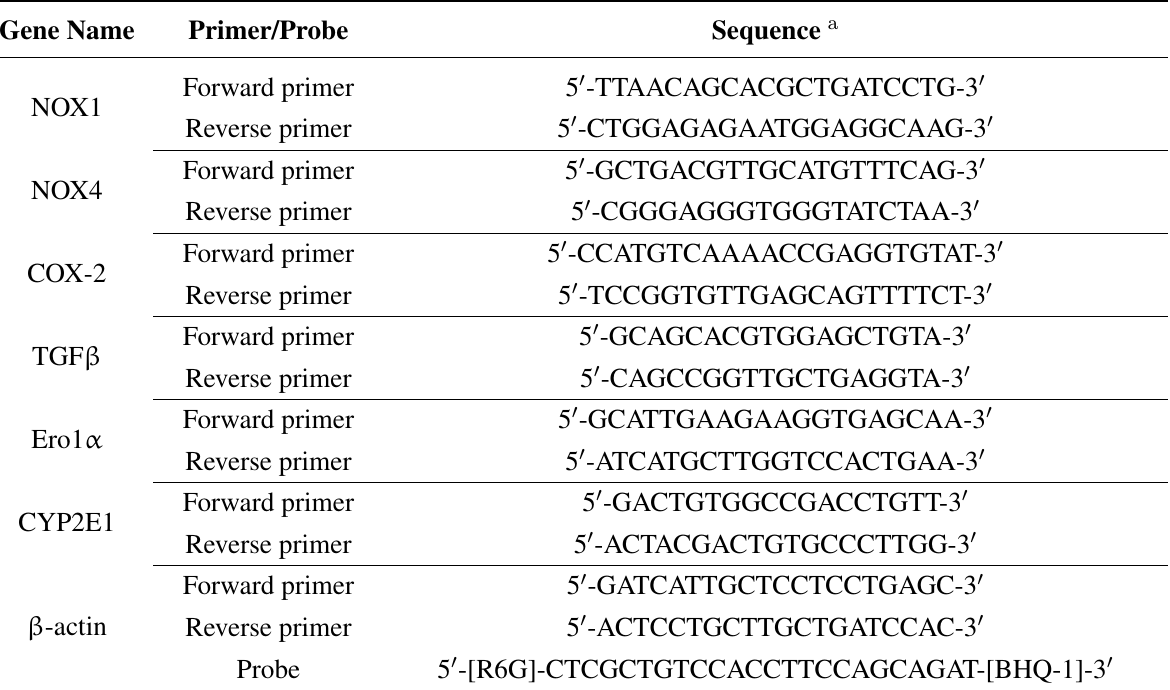
Table 1. Primers used for real-time PCR